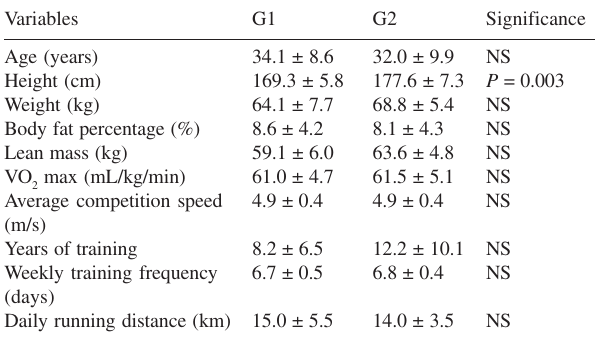
Table 1 - Anthropometric characteristics of the long distance-running athletes with and without anterior cruciate ligament